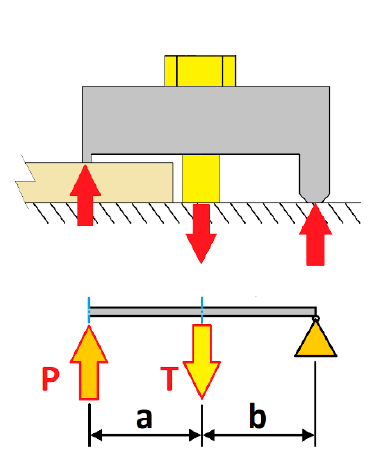
Figure 3. Diagram of the clamp operation (lever